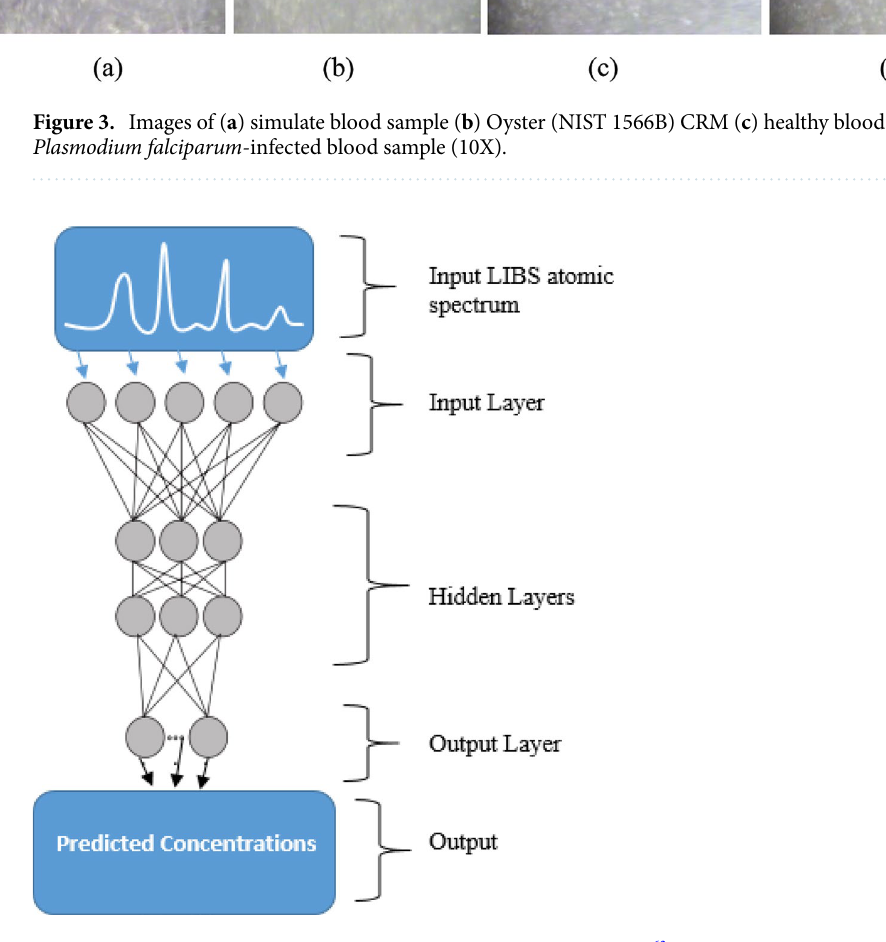
Figure 4. Schematic diagram of feed forward back propagation ANN 63